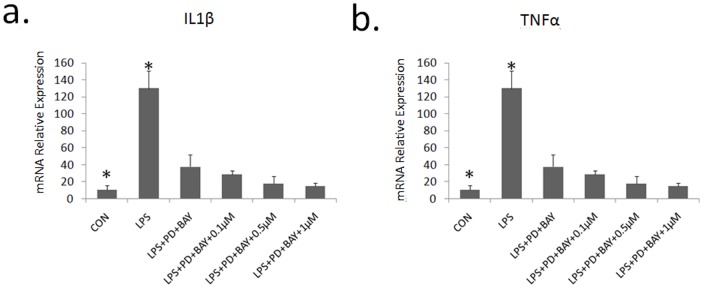
Effect of PD98059 and BAY 11–7082 on IL1β and TNFα expression in LPS-induced microglial activation.In order to clarify whether the inhibitory effect of TET on activated microglia is really mediated by ERK1/2 and NF-κB signaling pathways, BV2 cells were pretreated with PD98059, BAY 11–7082, and working concentrations of TET for 2 hours, then stimulated with LPS for an additional 24 hours. Then, the cells were lysed to extract total RNA. The mRNA levels of IL1β (Fig. 8a) and TNFα (Fig. 8b) were measured by real-time RT-PCR. Results were the mean ± S.D. from three independent experiments performed in triplicate. * P<0.05 compared with the LPS+PD+BAY group.